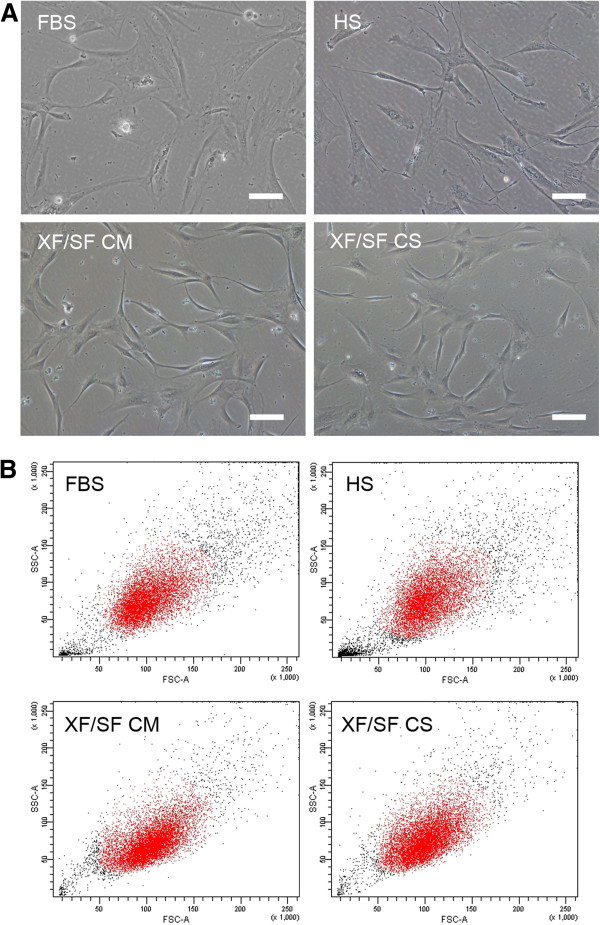
Cell morphology. (A) Morphologic images of cells cultured in different conditions: FBS, HS, XF/SF CM, and XF/SF CS at time point 4 days in passage 2. The morphology of ASCs grown in XF/SF medium is more spindle-shaped and smaller than in cells grown under serum-containing medium (FBS, HS). Scale bar, 100 μm. (B) Flow-cytometric analysis confirms the morphologic characteristics observed with light microscopy. In XF/SF culture conditions (CM and CS), the cell cloud in the forward and side scatter is more uniform and contains less debris than does a cloud of cells grown in FBS or HS medium, suggesting a more homogeneous population.